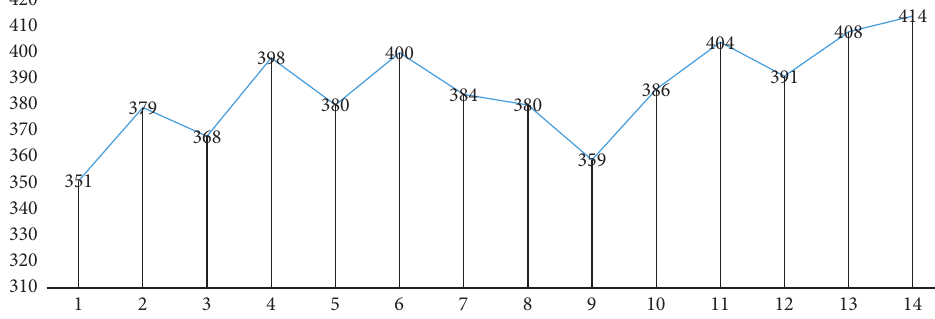
Figure 3: Category I: interaction-communication-empathy, motivation, and